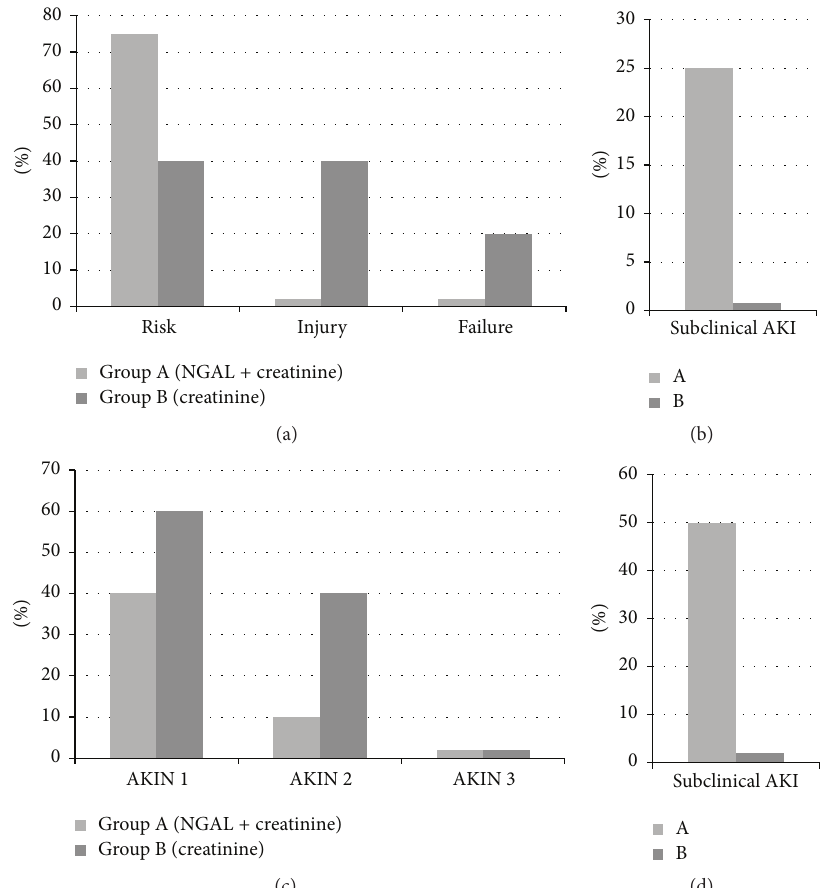
Figure 2: ((a) and (b)) Comparison of AKI severity, using RIFLE criteria, between Group A and Group B patients. ((c) and (d)) Comparison of AKI severity, using AKIN criteria, between Group A and Group B